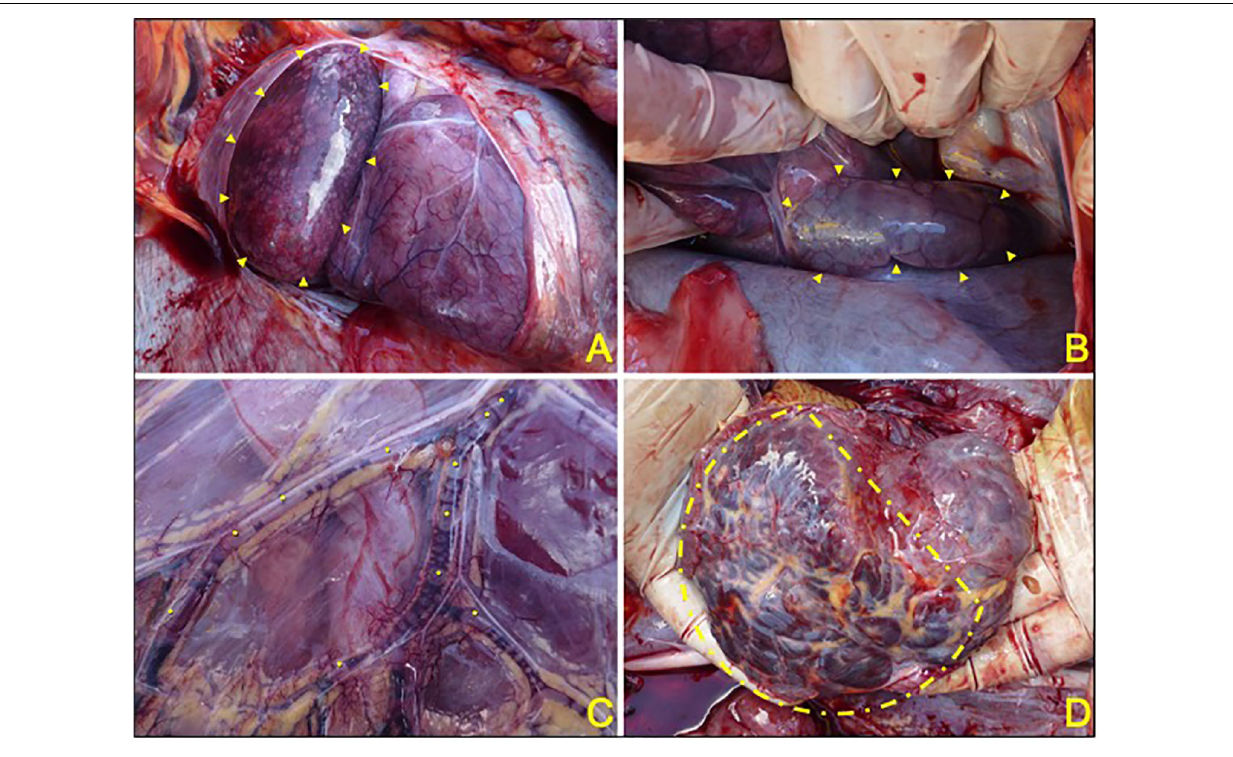
FIGURE 3 | Selected images from the olive ridley turtle necropsy affected with severe GE and DCS. (A) Opening of the pericardium, abundant gas bubbles are observed in the right atrium (arrowheads). (B) Large presence of gas in the venous sinus (arrowheads). (C) Presence of gas bubbles (asterisks) in mesenteric veins. (D) Marked congestion (dotted line area) of the renal